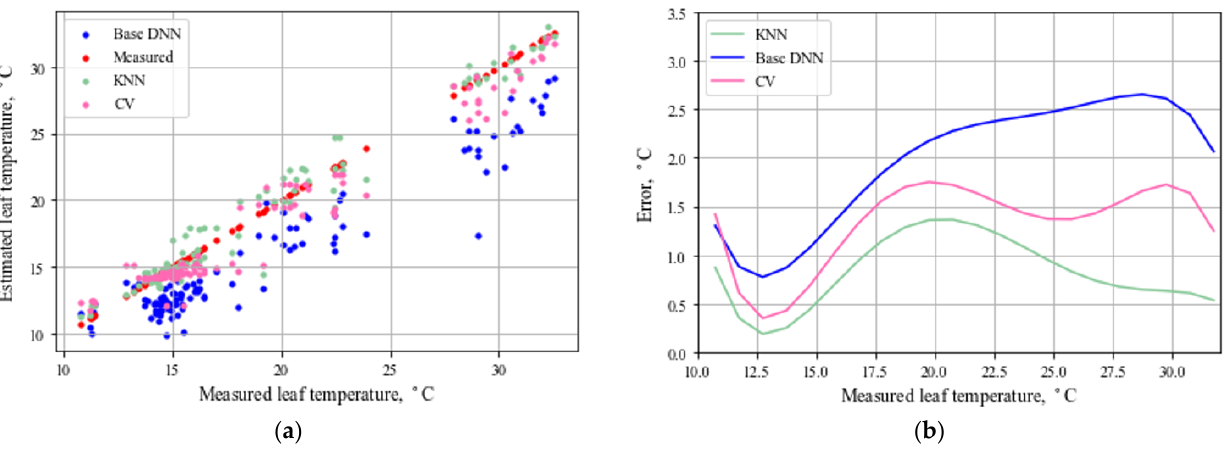
Figure 5. Leaf temperature and errors in estimation: ( a ) comparison between measured and predicted temperature; and ( b ) each model error as a function of the measured value.